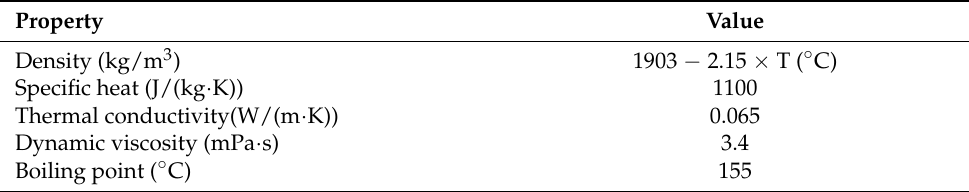
Figure 1. Computational domain ( a ) and heat sink ( b ). Table 1. The physical properties of FC-40.